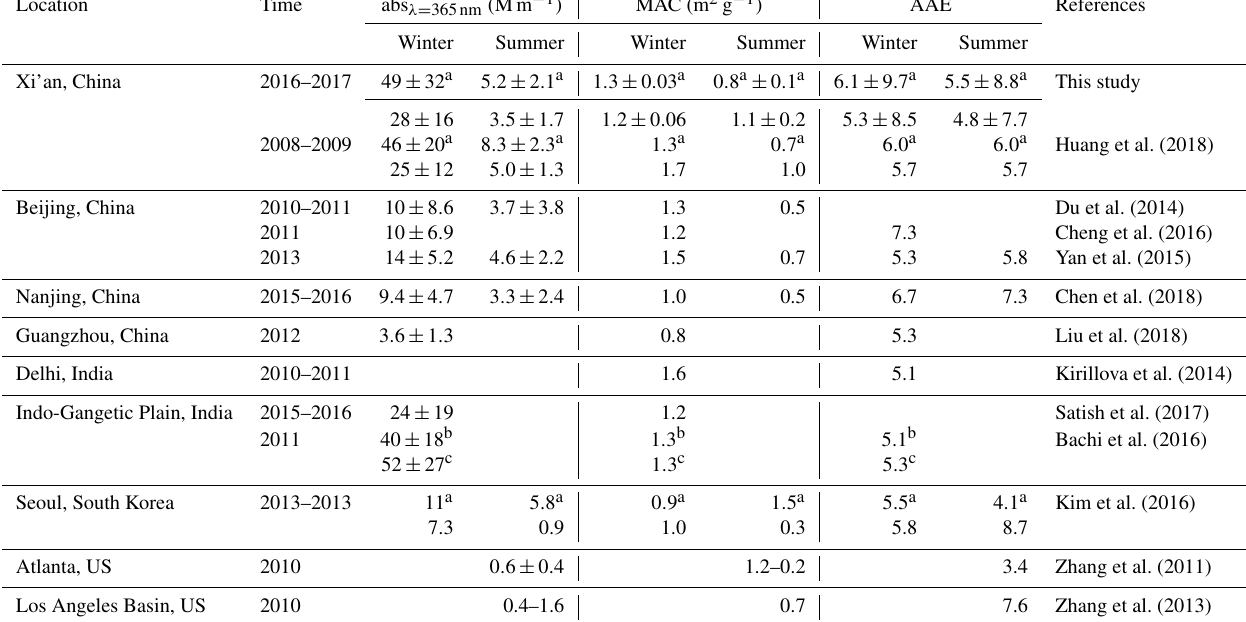
Table 2. Comparison of light absorption (abs λ = 365 nm ) , MAC and AAE values of water extracts of PM 2 . 5 in Xi’an, China, with those in other cities. Location